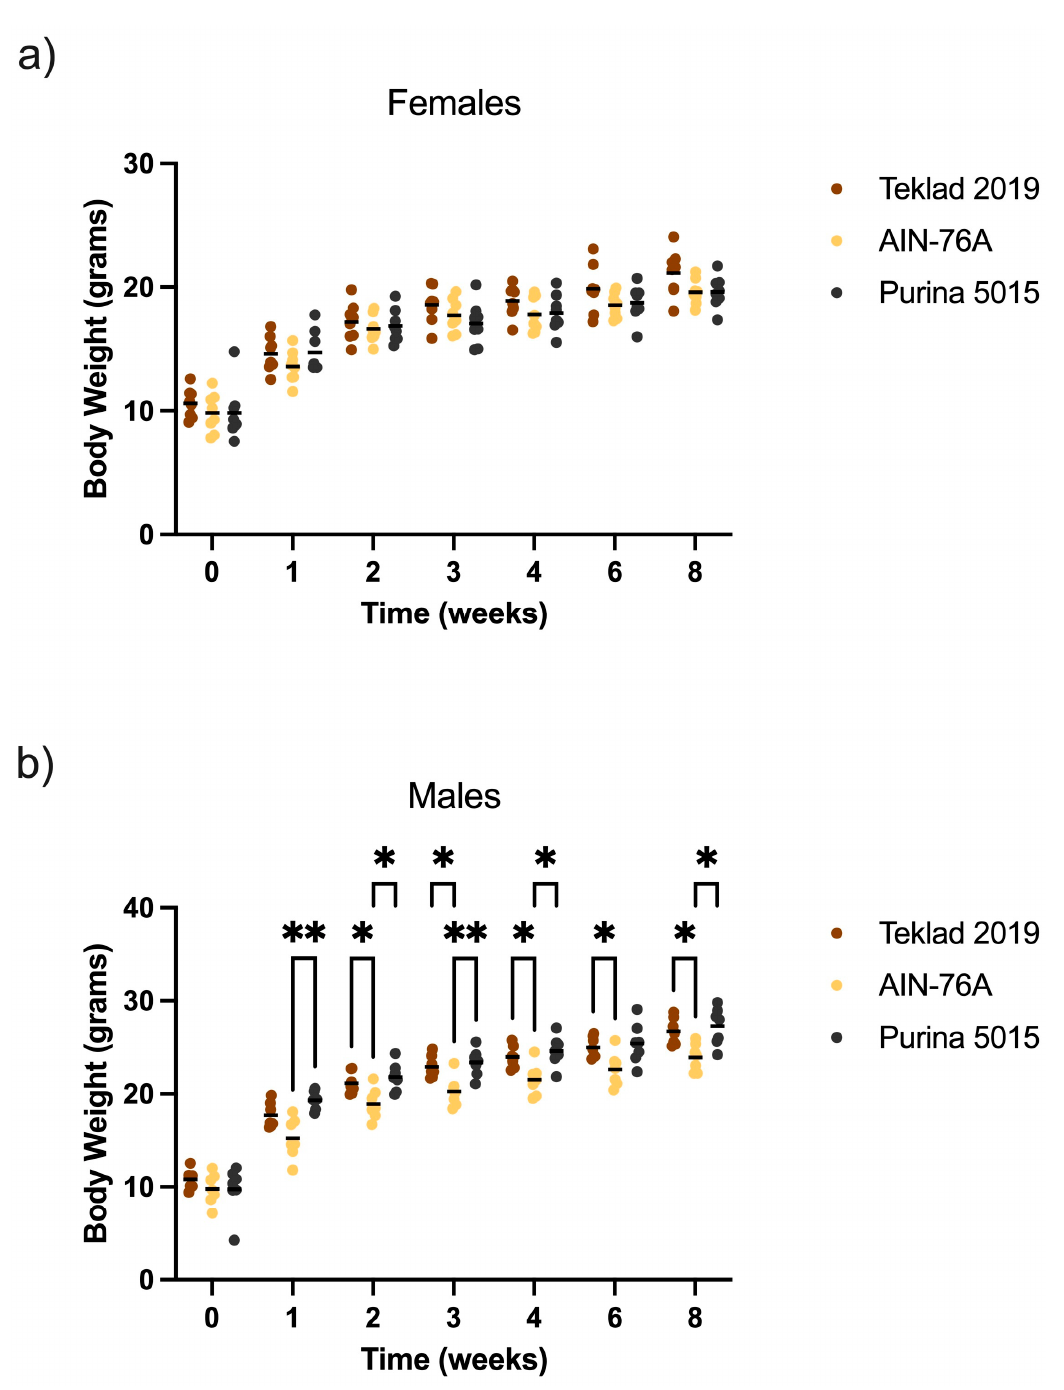
Figure 2. Mouse body weight as an effect of diet. Male and female C57BL/6J mice were weighed at age P21, randomized to diets (Teklad 2019, AIN-76A or Purina 5015), and weighed weekly for 4 weeks and biweekly thereafter. Body weight was plotted versus treatment time with diets. Statistics were determined by 2-way ANOVA and Tukey’s multiple comparison tests denoted by p < 0.05 (*) and p < 0.01 (**). ( a ) females ( n = 8 per diet); ANOVA results: time × diet F(12, 126) = 2.115, p = 0.02; time F(2.474, 51.94) = 591.6, p < 0.0001; diet F(2, 21) = 1.402, p = 0.27; and subject F(21, 126) = 26.05, p < 0.0001. ( b ) males ( n = 7 per diet). ANOVA results: time x diet F(12, 108) = 3.873, p < 0.0001; time F(2.111, 37.99) = 756.5 p < 0.0001; diet F(2, 18) = 7.924, p = 0.0034; and subject F(18, 108) = 16.87, p < 0.0001.